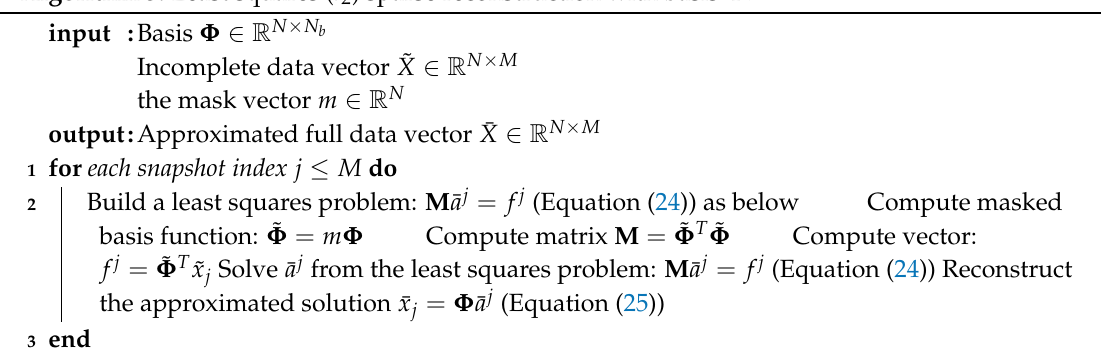
Algorithm 3: Least squares ( l 2 ) sparse reconstruction with basis Φ